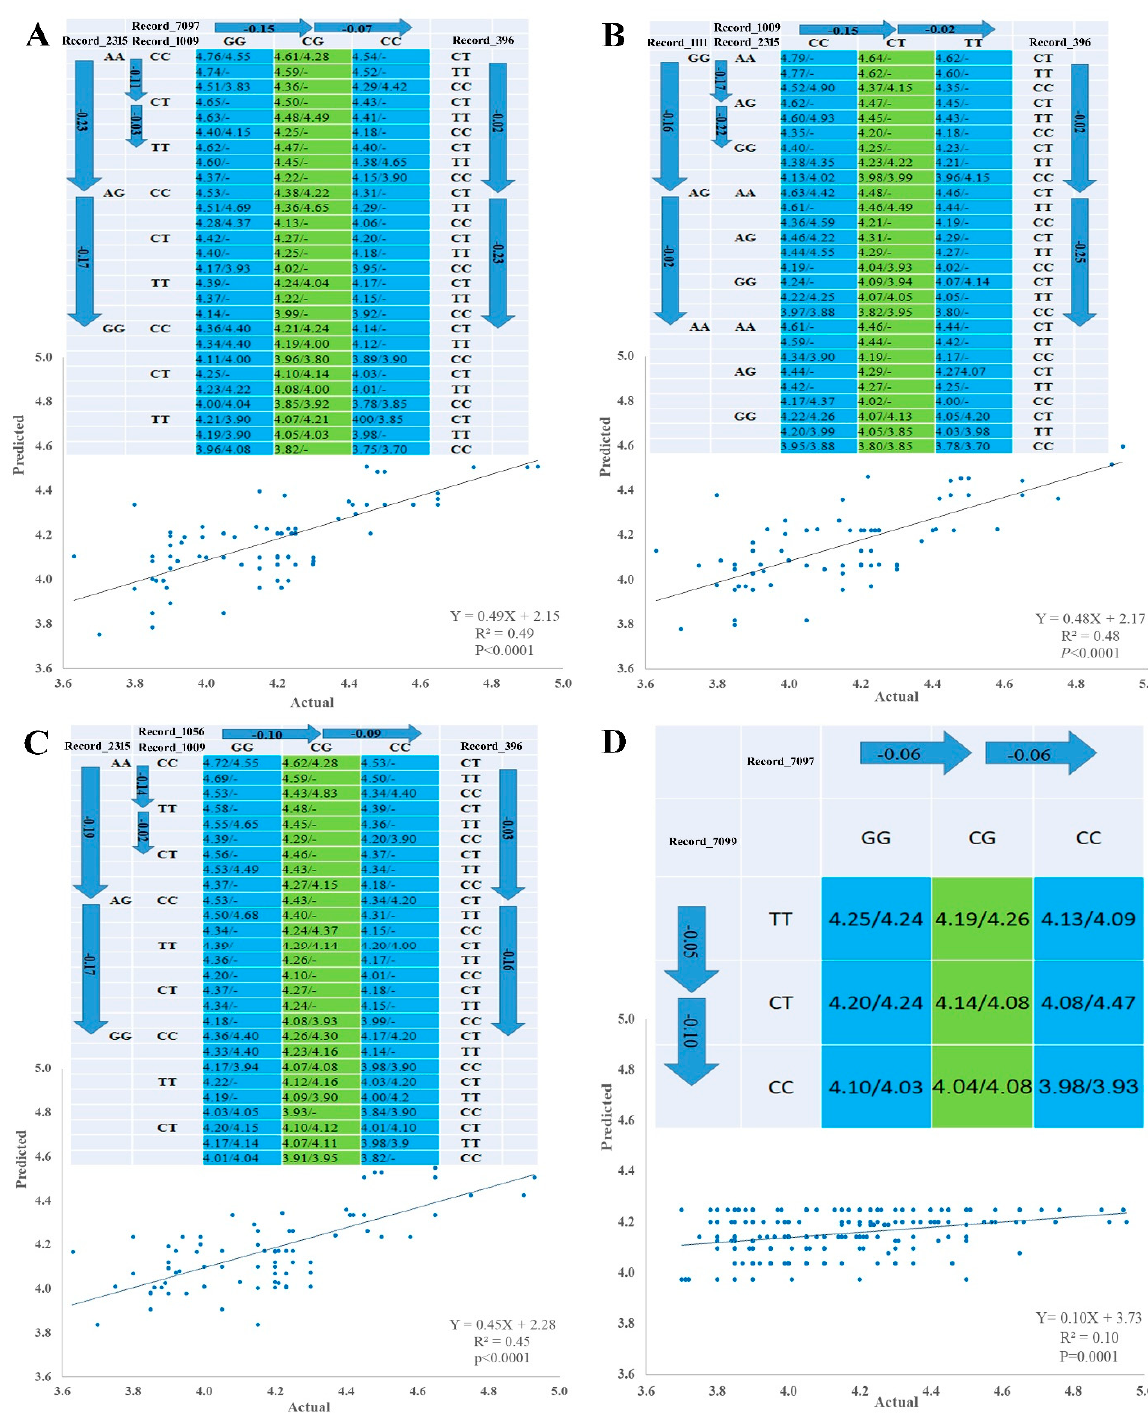
Figure 3. Genetic networks with multiple SNPs for marketing weight of male goslings. ( A ) Four SNP-networks for SNPs Record_2315, Record_1009, Record_7097 and Record_396 (SNP-network 1), ( B ) Four SNP-networks for SNPs Record_1111, Record_2315, Record_1009 and Record_396 (SNP-network 2), ( C ) Four SNP-networks for SNPs Record_2315, Record_1009, Record_1056 and Record_396 (SNP-network 3) and ( D ) Two SNP-networks for SNPs Record_7099 and Record_7097 (SNP-network 8). The X and Y axes represent actual and predicted MW (kg), respectively.